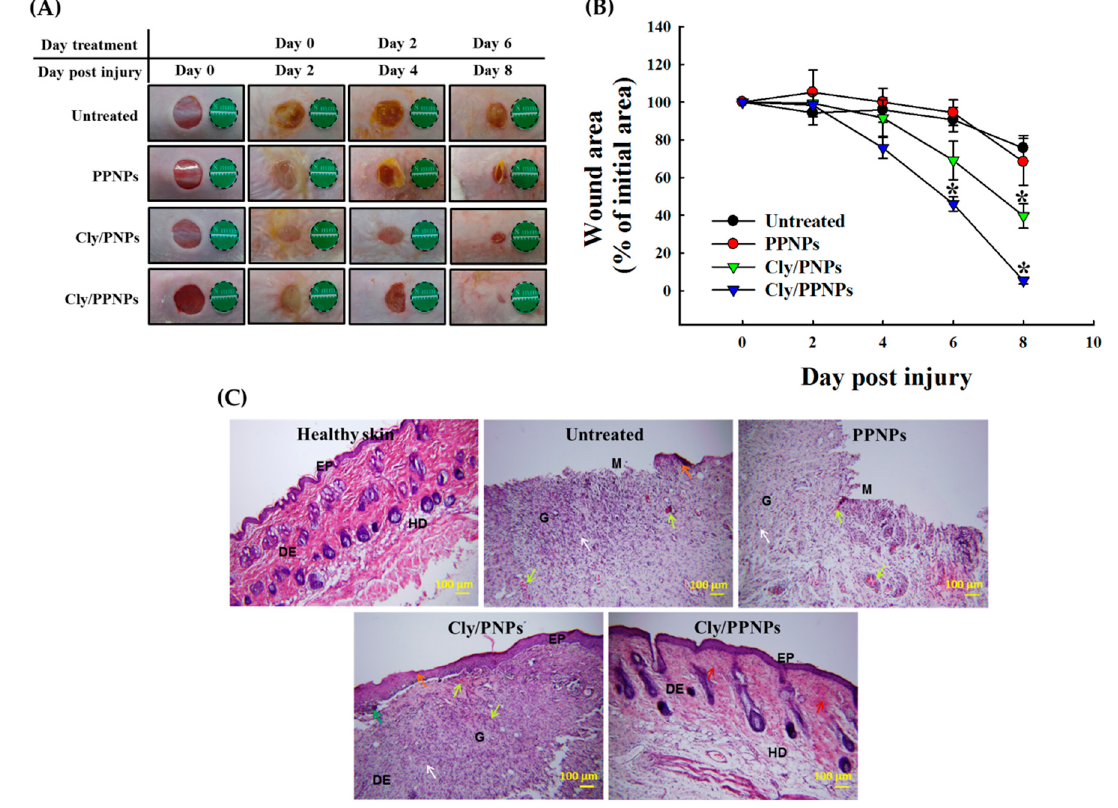
Figure 6. Wound healing assay in mice. ( A ) Representative photographs of methicillin-resistant Staphylococcus aureus (MRSA)-infected wounds of ICR mice treated with or without PPNPs, Cly/PNPs, and Cly/PPNPs. ( B ) Area reduction (%) profiles of the wounds. Values are mean ± SD, n = 10 different wounds, “*” indicates p < 0.05 compared with untreated group. ( C ) Histological analysis (H&E staining) of MRSA-infected wounds of ICR mice at day 8. Scale bar = 100 µ m. Ep = epidermal, DE = dermal junction, HD = hypodermis, G = granulation tissue, and M = wound matrix. The orange arrows indicate early epithelialization. The green arrow shows skin crust, red arrows indicate fibroblast cells, white arrows denote mononuclear inflammatory cells and yellow arrows show neovascularization.